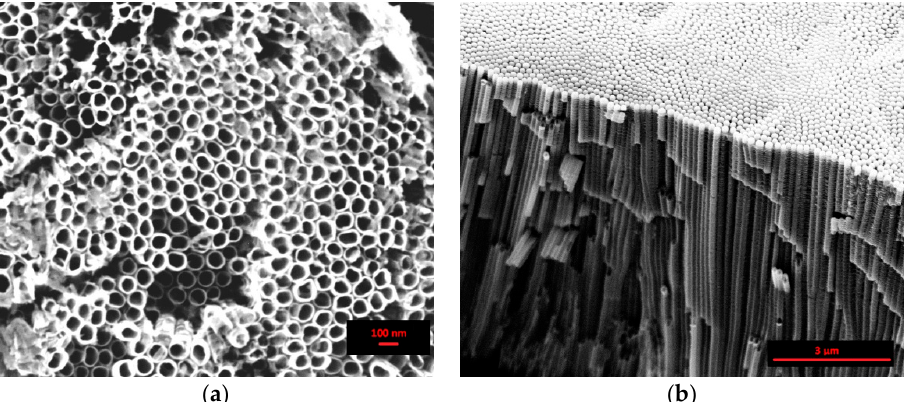
Figure 1. Scanning electron microscopy (SEM) images of the anodized sample in the “organic” solution at 30 V for 1080 min: ( a ) top view and ( b ) cross sectional view.